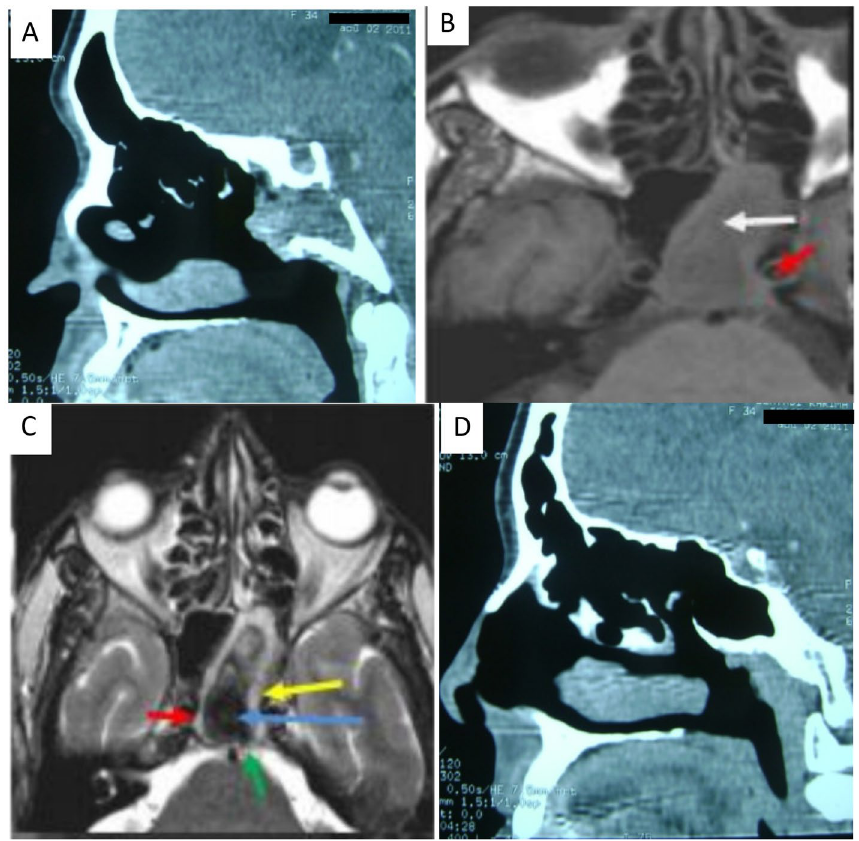
Fig. 5 Case 5. Pseudotumoral invasive sinusitis. CT scan sagittal view ( A upper left) showing total tissue filling of the sphenoidal sinus with clivus partial destruction. MRI T1-weighted sequence axial view ( B upper right) showing an intermediate T1 signal total filling of the left sphenoid sinus (white arrow). MRI T2-weighted sequence axial view ( C lower left) showing a hyposignal total filling of the left sphenoid sinus (blue arrow) that encounters close contact with the internal carotid artery (red arrow), basilar trunk (green arrow), and an inflammatory mucosa (yellow arrow), all for a pseudotumoral invasive sinusitis. Postoperative CT scan sagittal view ( D lower right) showing a complete removal of the sphenoid sinus pathology